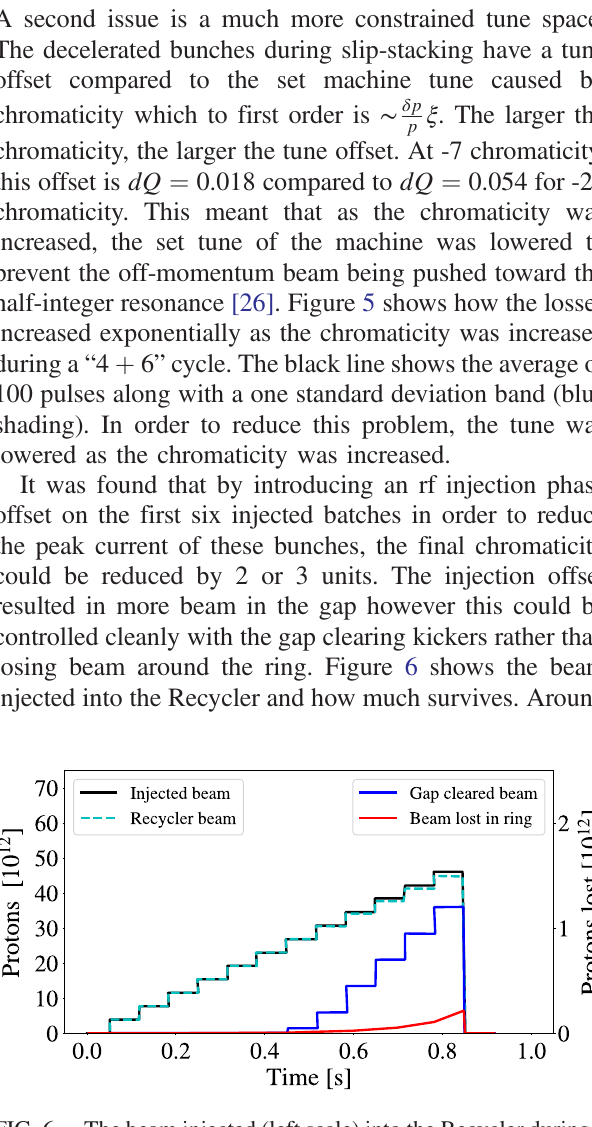
FIG. 6. The beam injected (left scale) into the Recycler during a “ 6 þ 6 ” cycle along with the gap cleared beam and beam lost (right scale) in the ring in